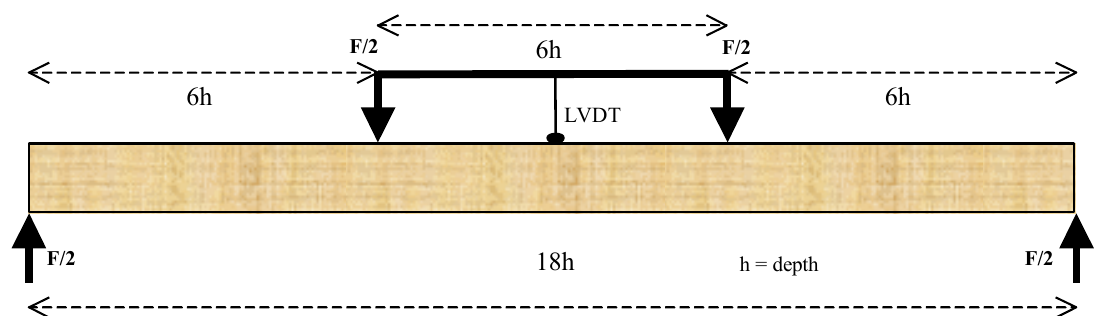
Figure 2. Schematic of four-point bending test set